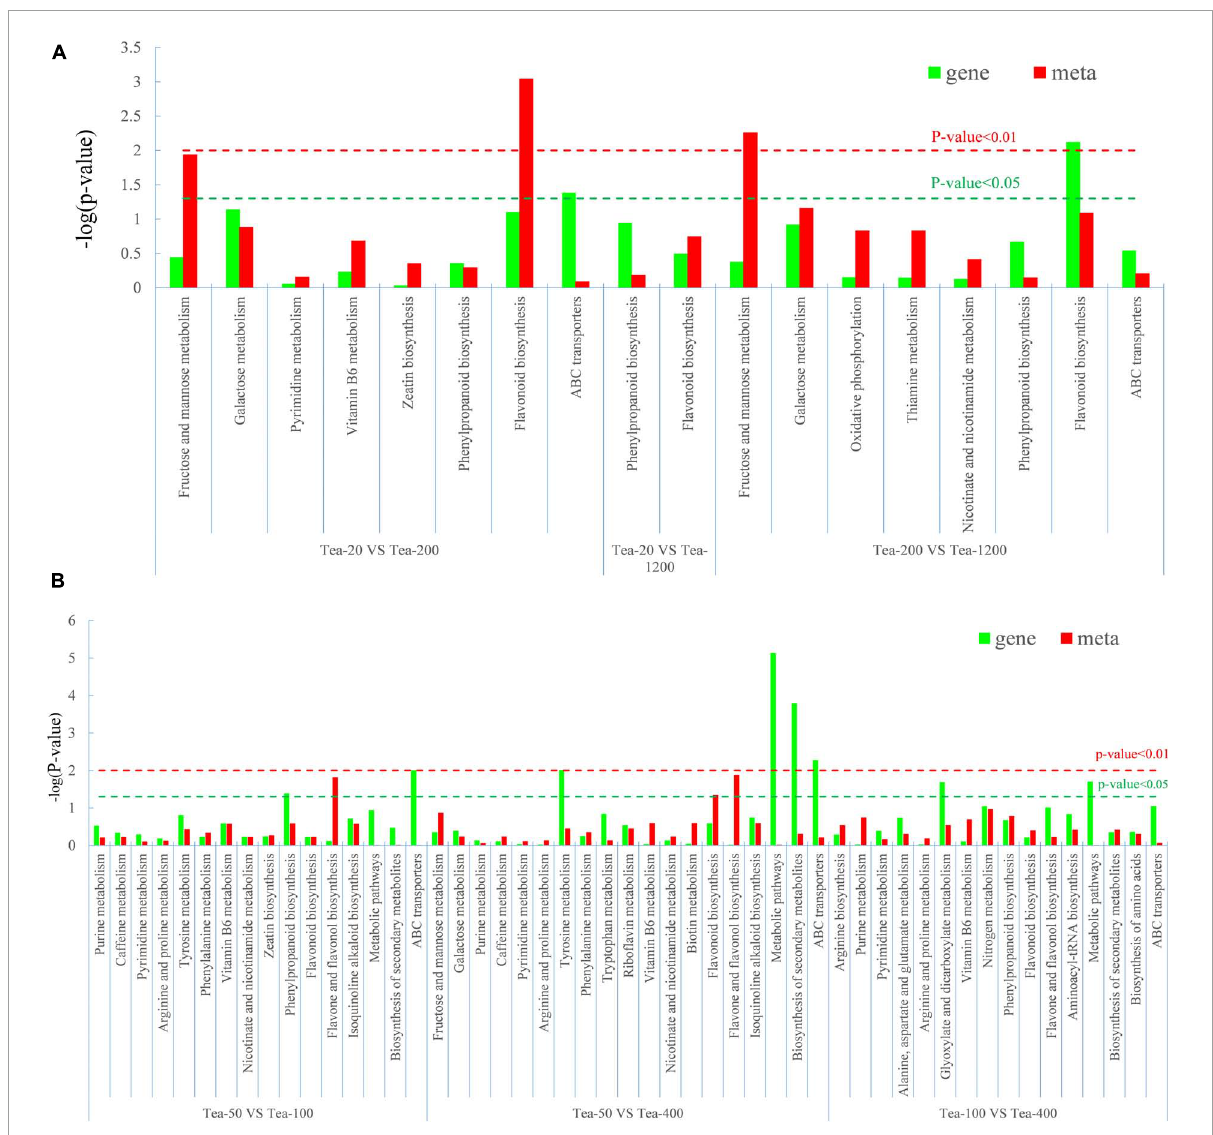
FIGURE11 Degree of relevant pathway enrichment of differential metabolites and differentially expressed genes (DEGs). (A) Group JP and (B) Group